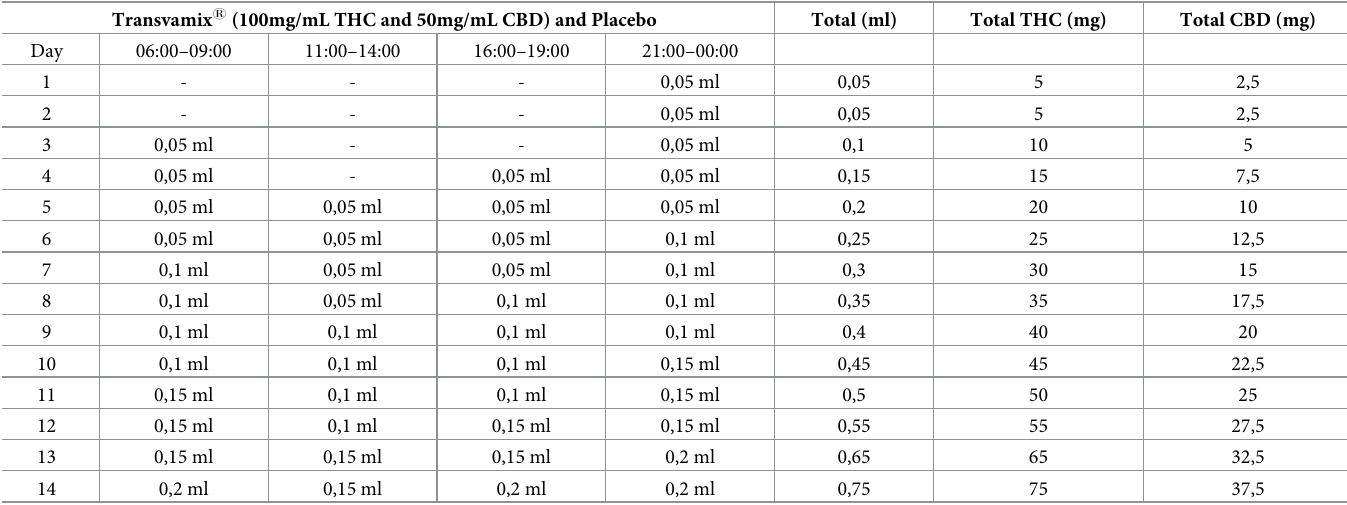
Table 2. Titration scheme employed by study participants. Transvamix 1 (100mg/mL THC and 50mg/mL CBD) and